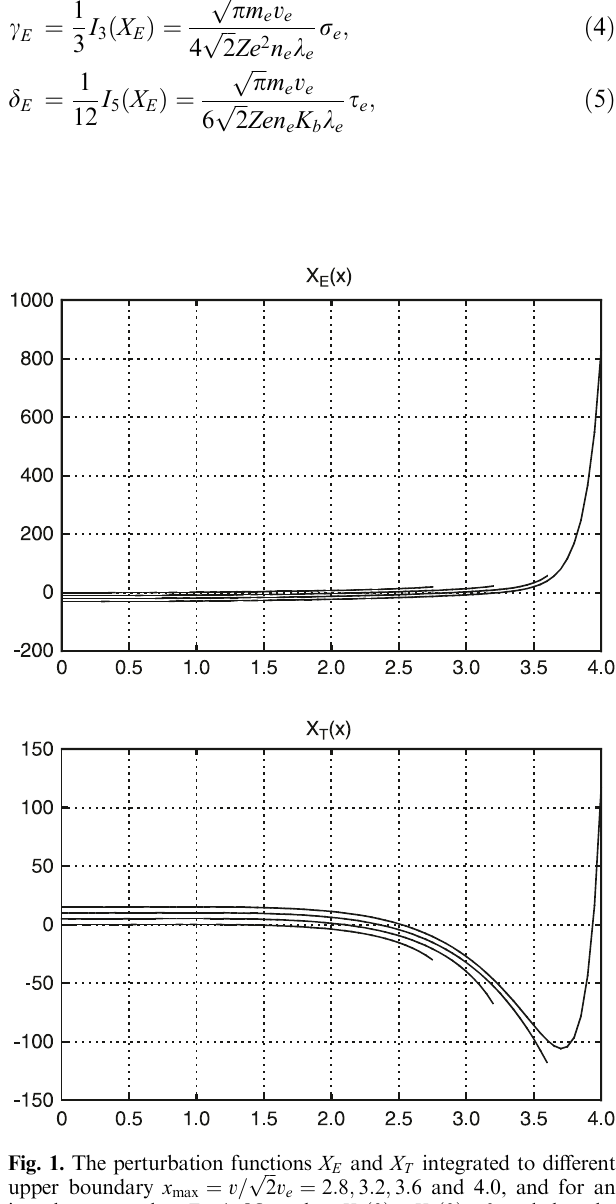
Fig. 1. The perturbation functions X E and X T integrated to di(cid:128)erent upper boundary